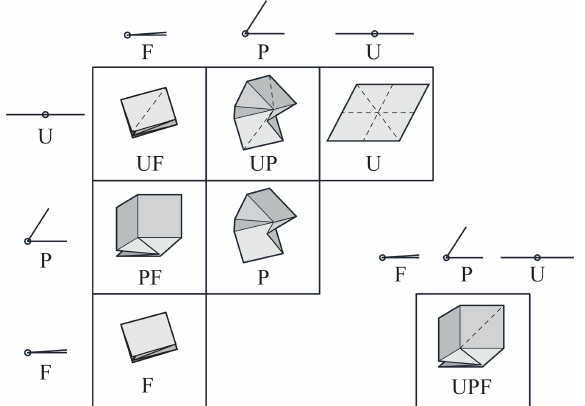
Figure 20. An examples of how fold angles from each sets ( U , P and F ) can be combined to form different fold states. Each vertex is an example of one of the seven fold states (larger depictions of the vertices are given with there respective fold state in Sect. 4).